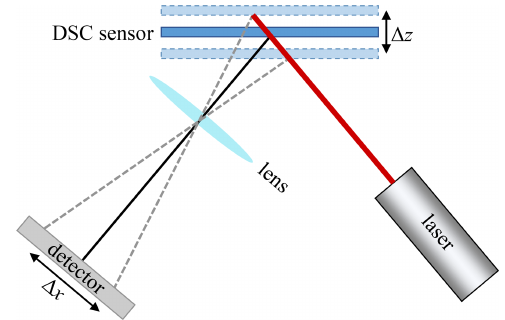
Figure 8. Principle of optical measurement on the sensor chip.